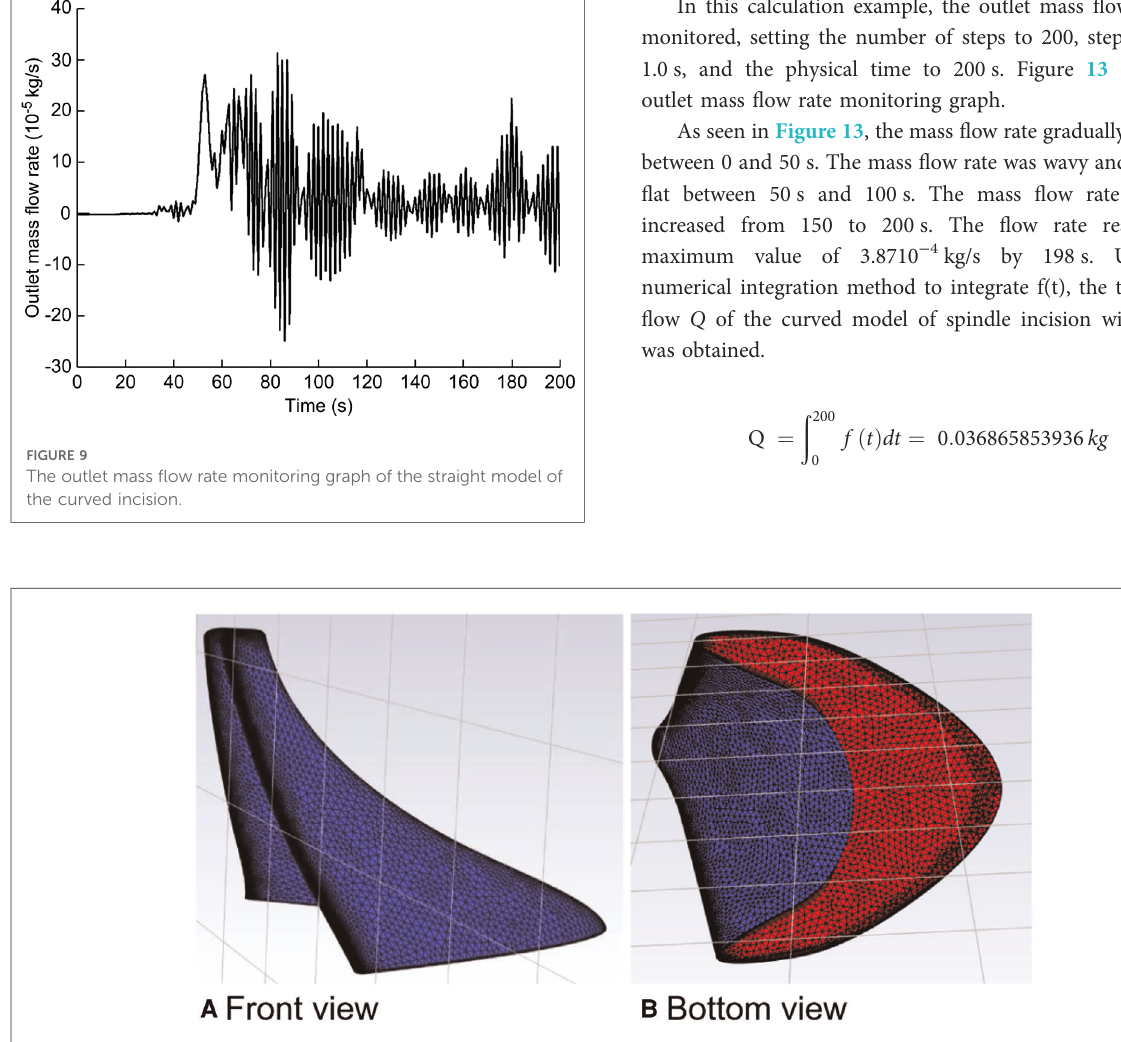
FIGURE 10 Curved model of the curved